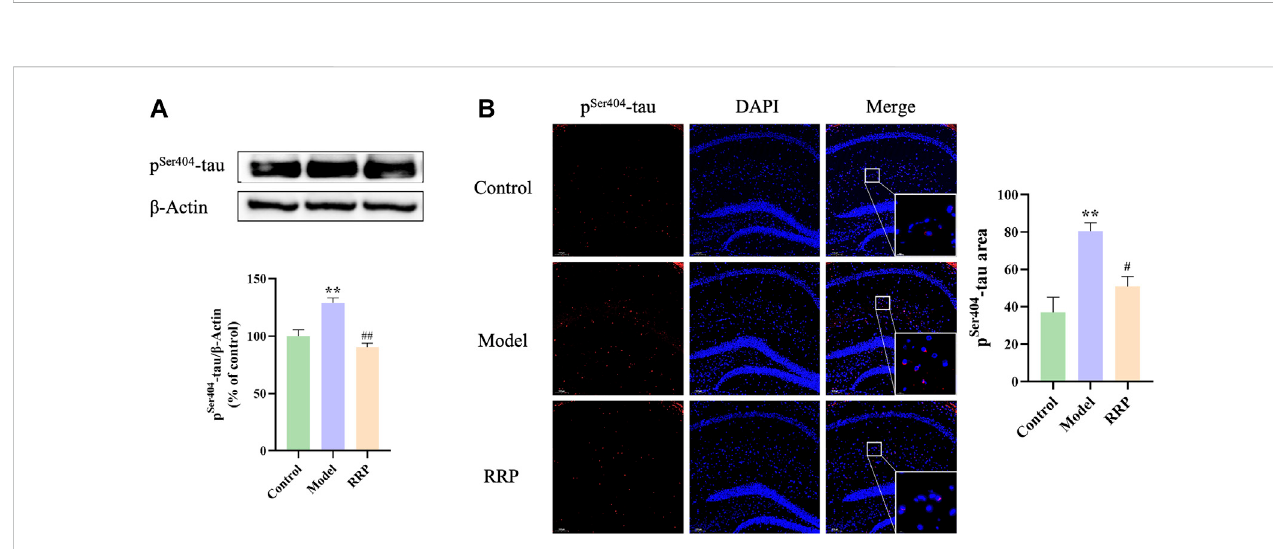
FIGURE 3 Western-blot and IF staining of p Ser404 -tau protein in hippocampus of mice in each group. (A) . Expression levels of p Ser404 -tau protein in hippocampus tissues; (B) . p Ser404 -tau protein staining (red) and nuclei re-stained (blue) (Magni fi cation ×100, partial enlarged is Magni fi cation ×1000). Each bar with vertical line represents the mean ± SD of three mice per